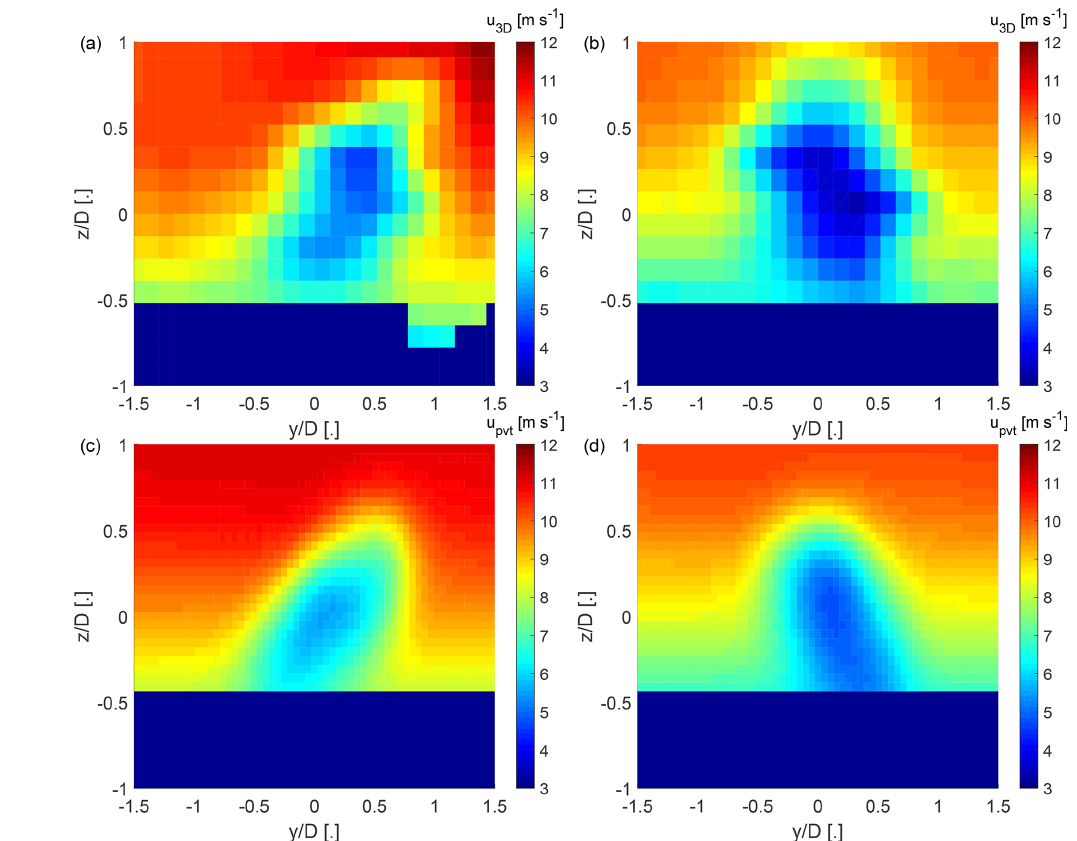
Figure B1. Span-wise cross sections of the longitudinal velocity field at x/D = 4. Panels (a) and (b) show the velocity deficit from 3D scans of the wake-scanning Doppler lidar, and panels (c) and (d) show the results from the model of Zong and Porté-Agel (2020). Panels (a) and (c) are a case with a positive wind veer of 0.09 ◦ m − 1 , and panels (b) and (d) are a case with a negative wind veer of − 0 . 06 ◦ m − 1